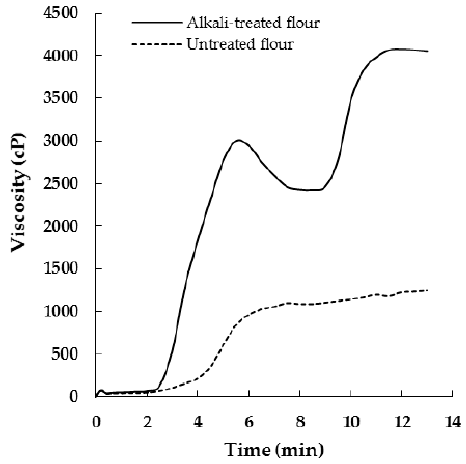
Figure 1. Viscosity of untreated and alkali-treated defatted rambutan seed flours.